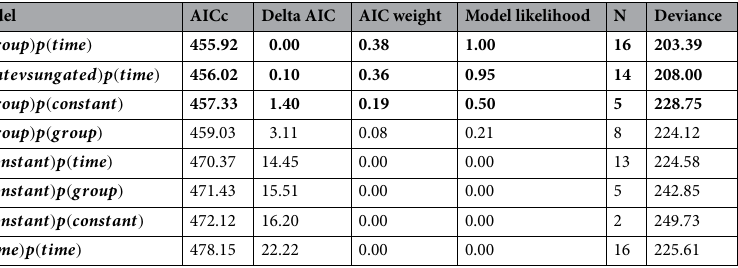
Table 3. Results of Cormack–Jolly–Seber analyses in MARK that was used to model rates of survival (S) and recapture (p) of broad-headed snakes. The best supported models (with delta AIC < 2) are in bold font. Each snake was assigned to one of four groups depending on its size at first capture (sub-adults and adults, or juveniles) and population (gated or ungated). Table shows AIC values and associated AIC weights, model likelihood, number of parameters (N), and model deviance.